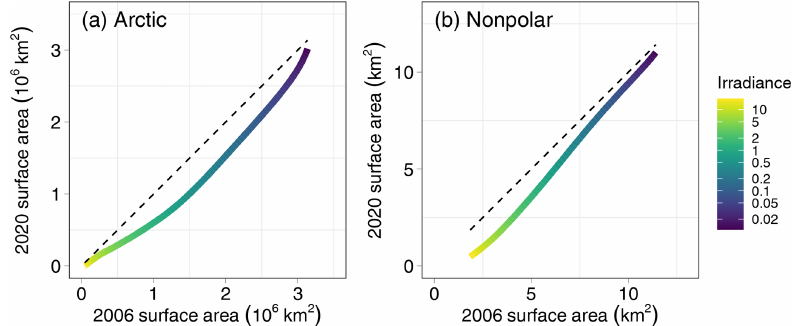
Figure 3. Comparison of the surface area of the seafloor of the Arctic (a) and nonpolar (b) regions receiving an irradiance larger than a threshold value ranging from 0.01 to 20molphotonsm − 2 d − 1 calculated in the present paper (2020) compared with the surface area reported by Gattuso et al. (2006). The dotted line is the 1 : 1